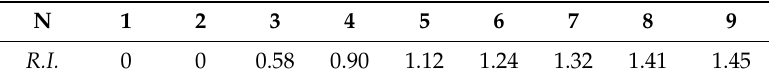
Table 2. Values of the random consistency index